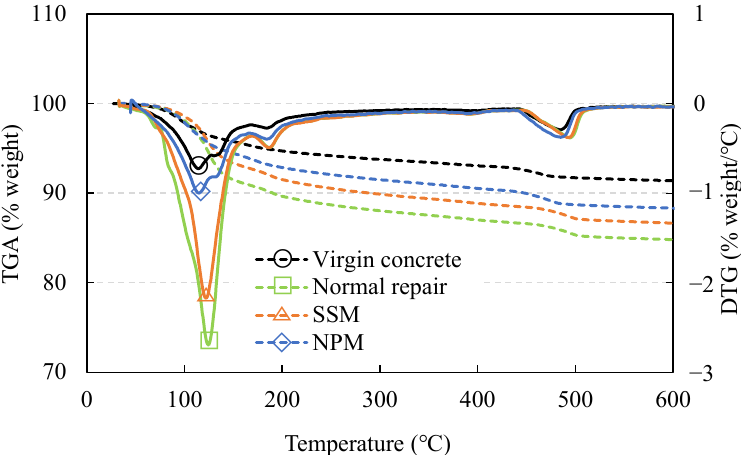
Figure 14. Thermal analysis of coated concrete samples immersed in 5% sulfuric acid solution for 28 days.